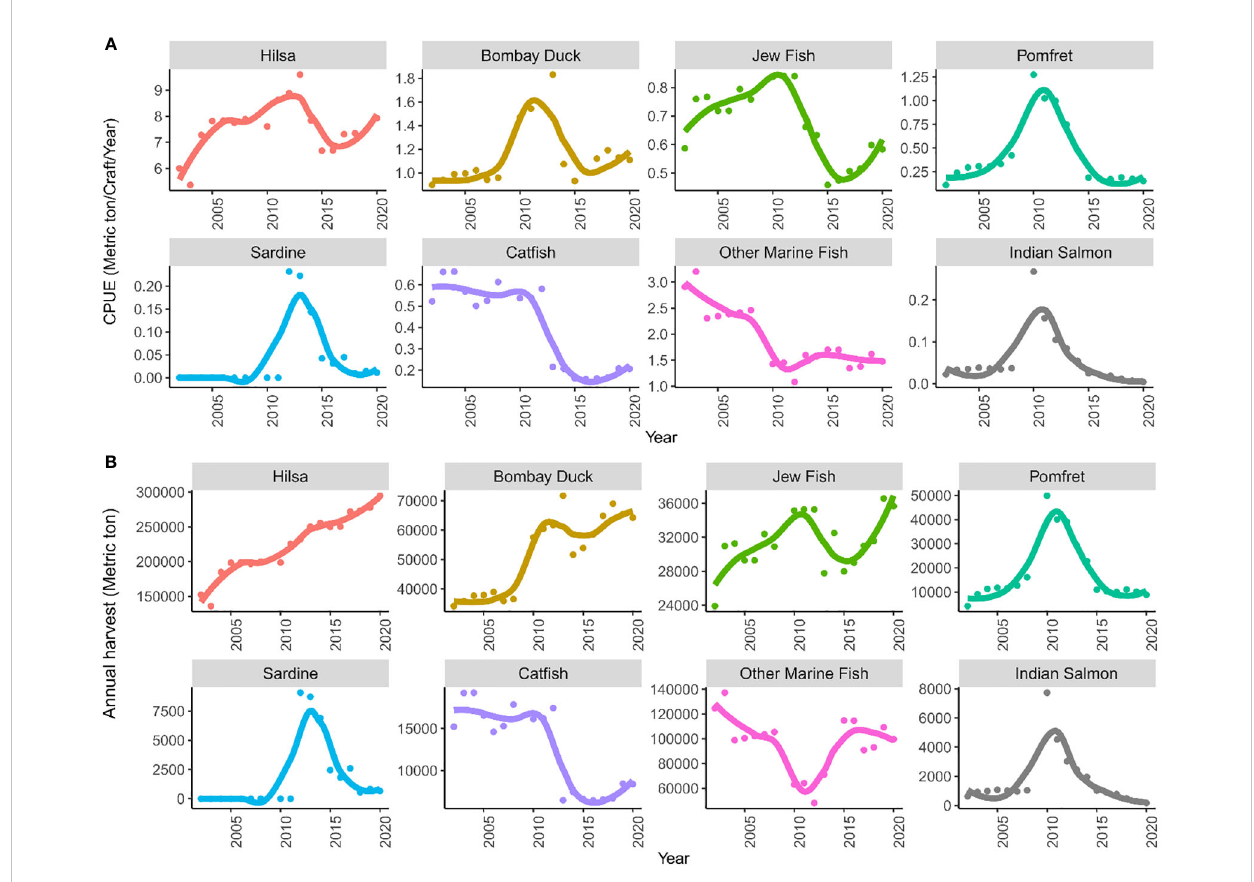
FIGURE 4 Trends in landed catches by small-scale fi shers in the Bay of Bengal from 2002 to 2020 (FRSS data). (A) CPUE (metric ton/craft/year). (B) Total annual harvest by major groups (metric